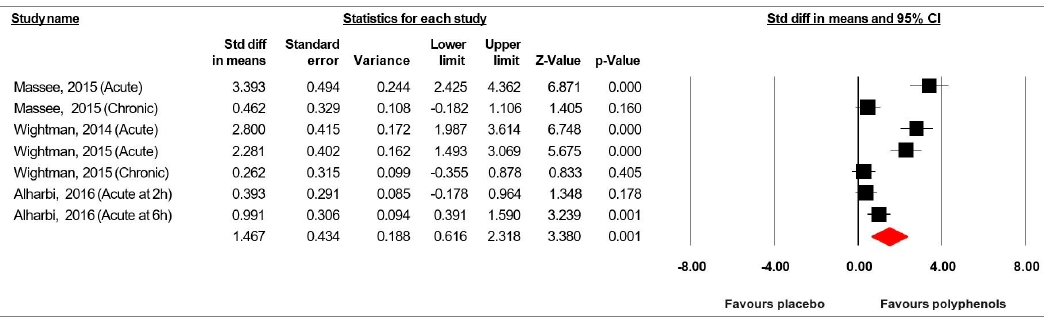
Figure 8. Forest plot of studies investigating the effect of (poly) phenol-rich supplementation on Serial Sevens subtraction task (correct in number) (SS-7s).